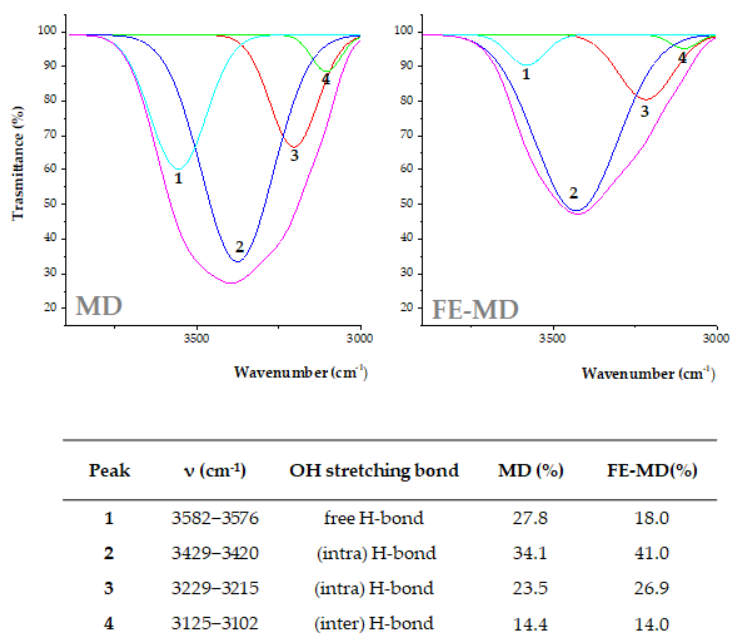
Figure 2. OH stretching band deconvolution FTIR spectra from MD and FE-MD using the Gaussian model. Percentage area peaks from deconvoluted signals are also reported.